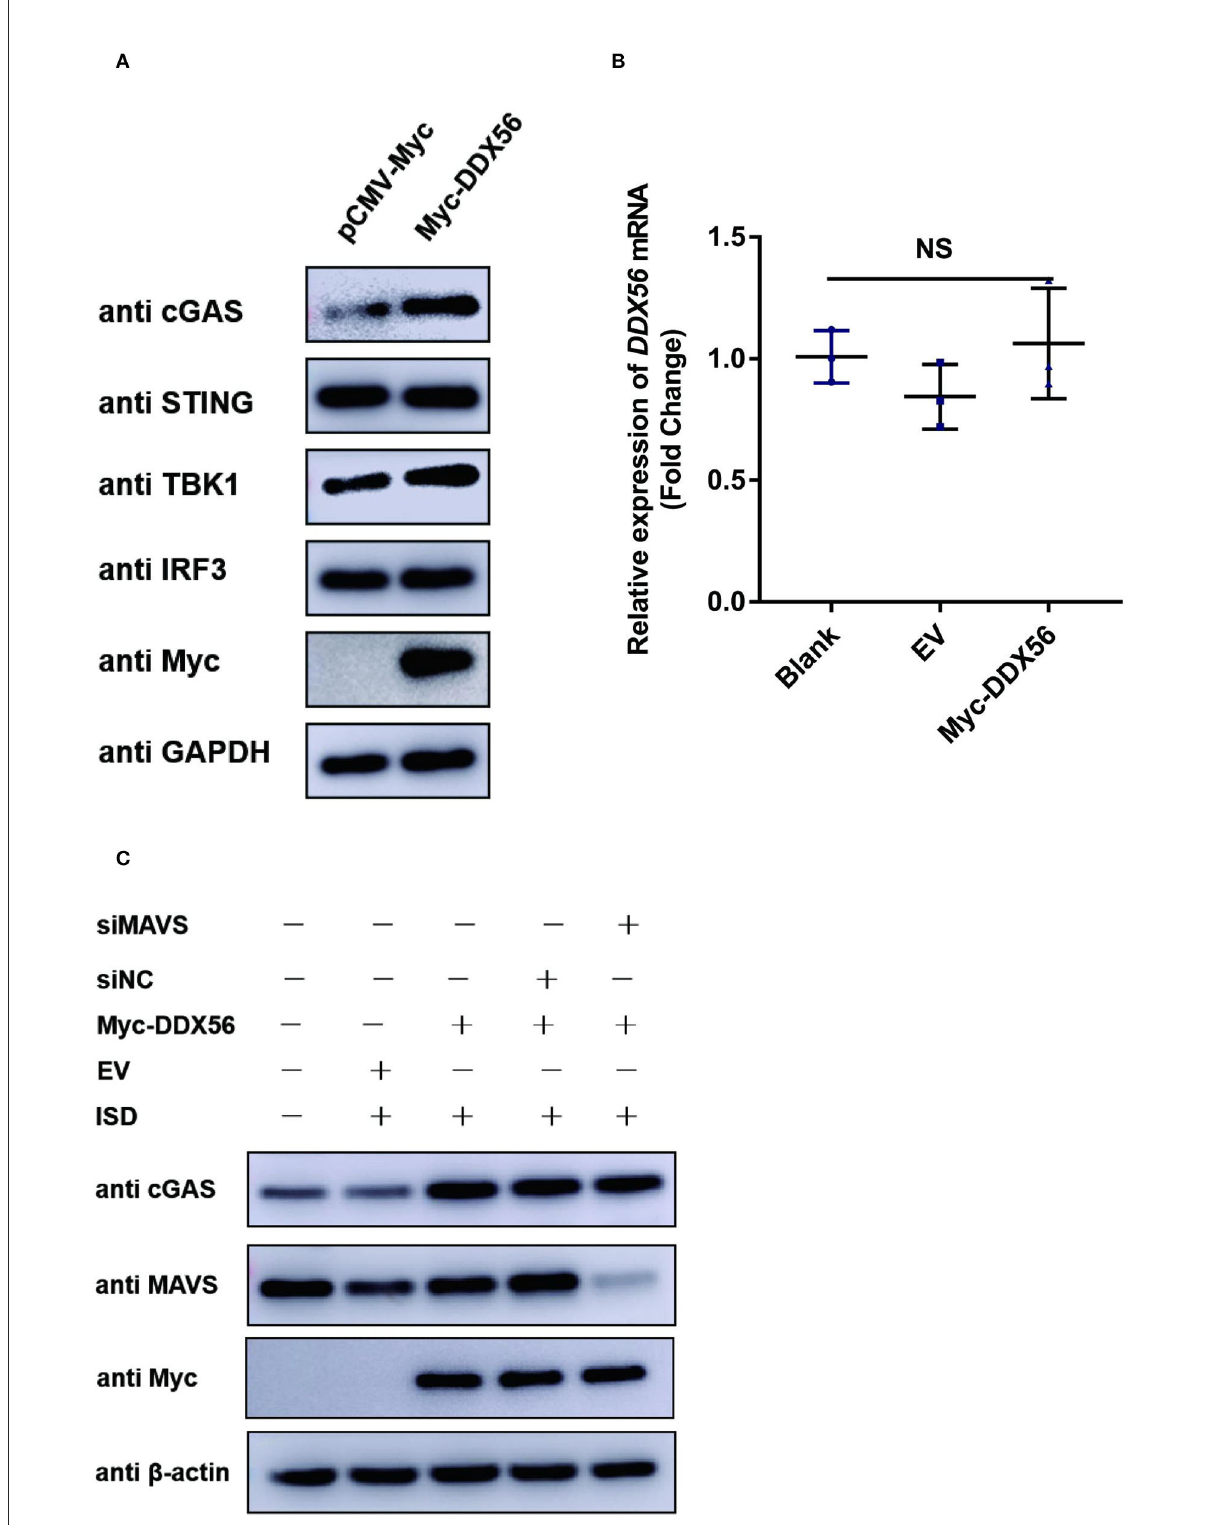
FIGURE4 DDX56 promotes endogenous cGAS expression. (A) Empty vector (EV, 1 µ g) or pCMV-Myc-DDX56 (1 µ g) plasmid was transfected into PK15 cells for 24h, and cells were collected for western blot analysis using specific antibodies to detect the expression of cGAS(58 kDa), STING(42